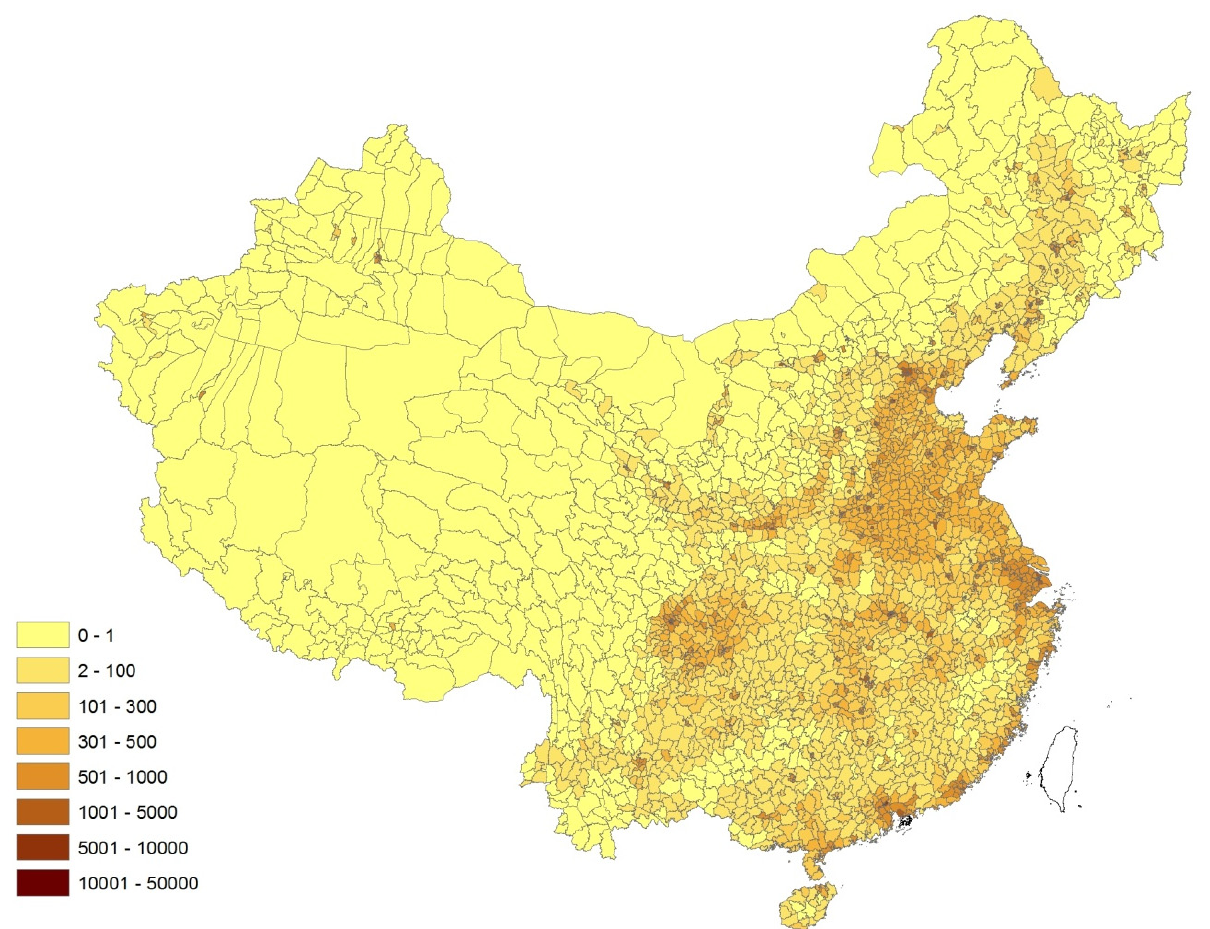
Figure A1. Map of county population density in China ( n =